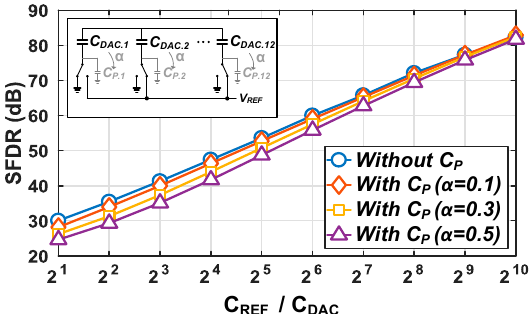
Figure 14. SFDR of a behavioral simulation of a 12-bit SAR ADC with the CRD only according to the total capacitance of parasitic capacitors (C P ).